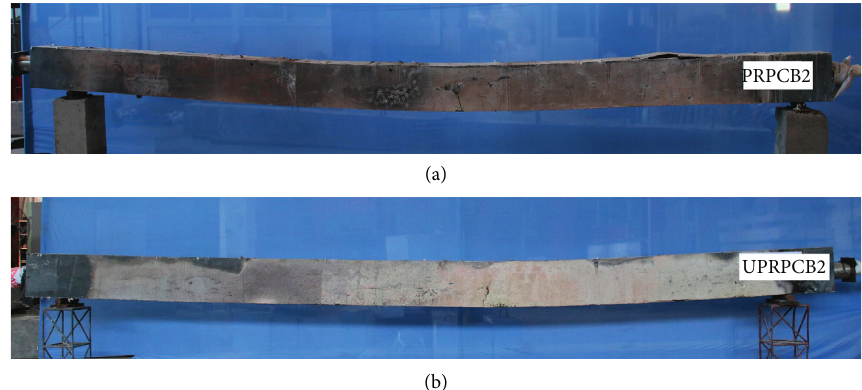
Figure 4: The specimen morphology after fire. (a) PRPCB2. (b)